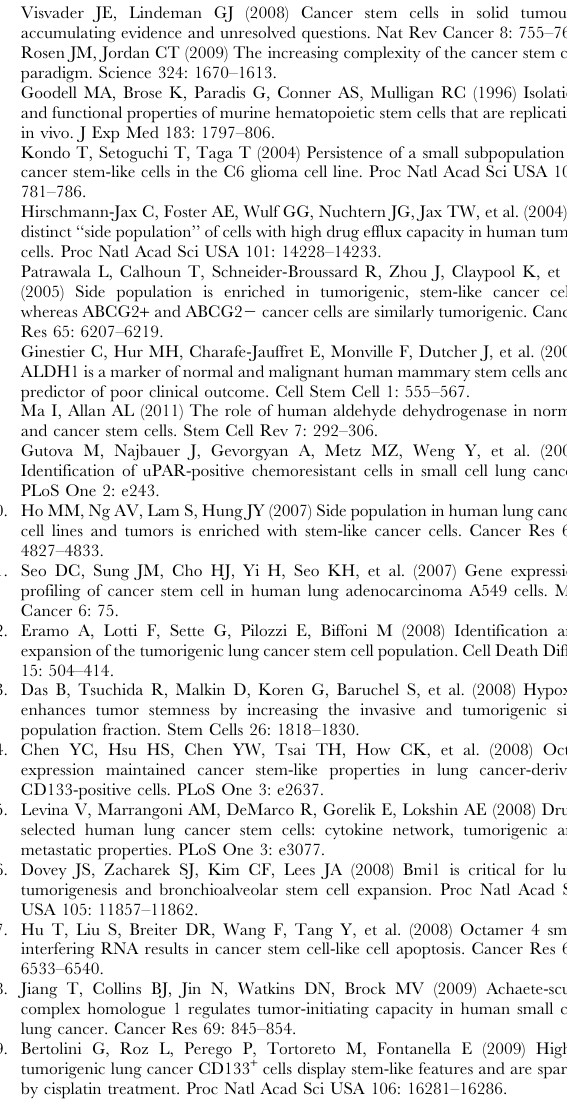
Figure 6. Cyclopamine inhibits H460 cell proliferation. A–C, Representative photomicrographs of H460 cells 72 h after treatment with vehicle control (A), Tomatidine (B), or Cyclopamine (C). Original maginifications: 6 200. D, Cyclopamine dose-dependently inhibited H460 cell